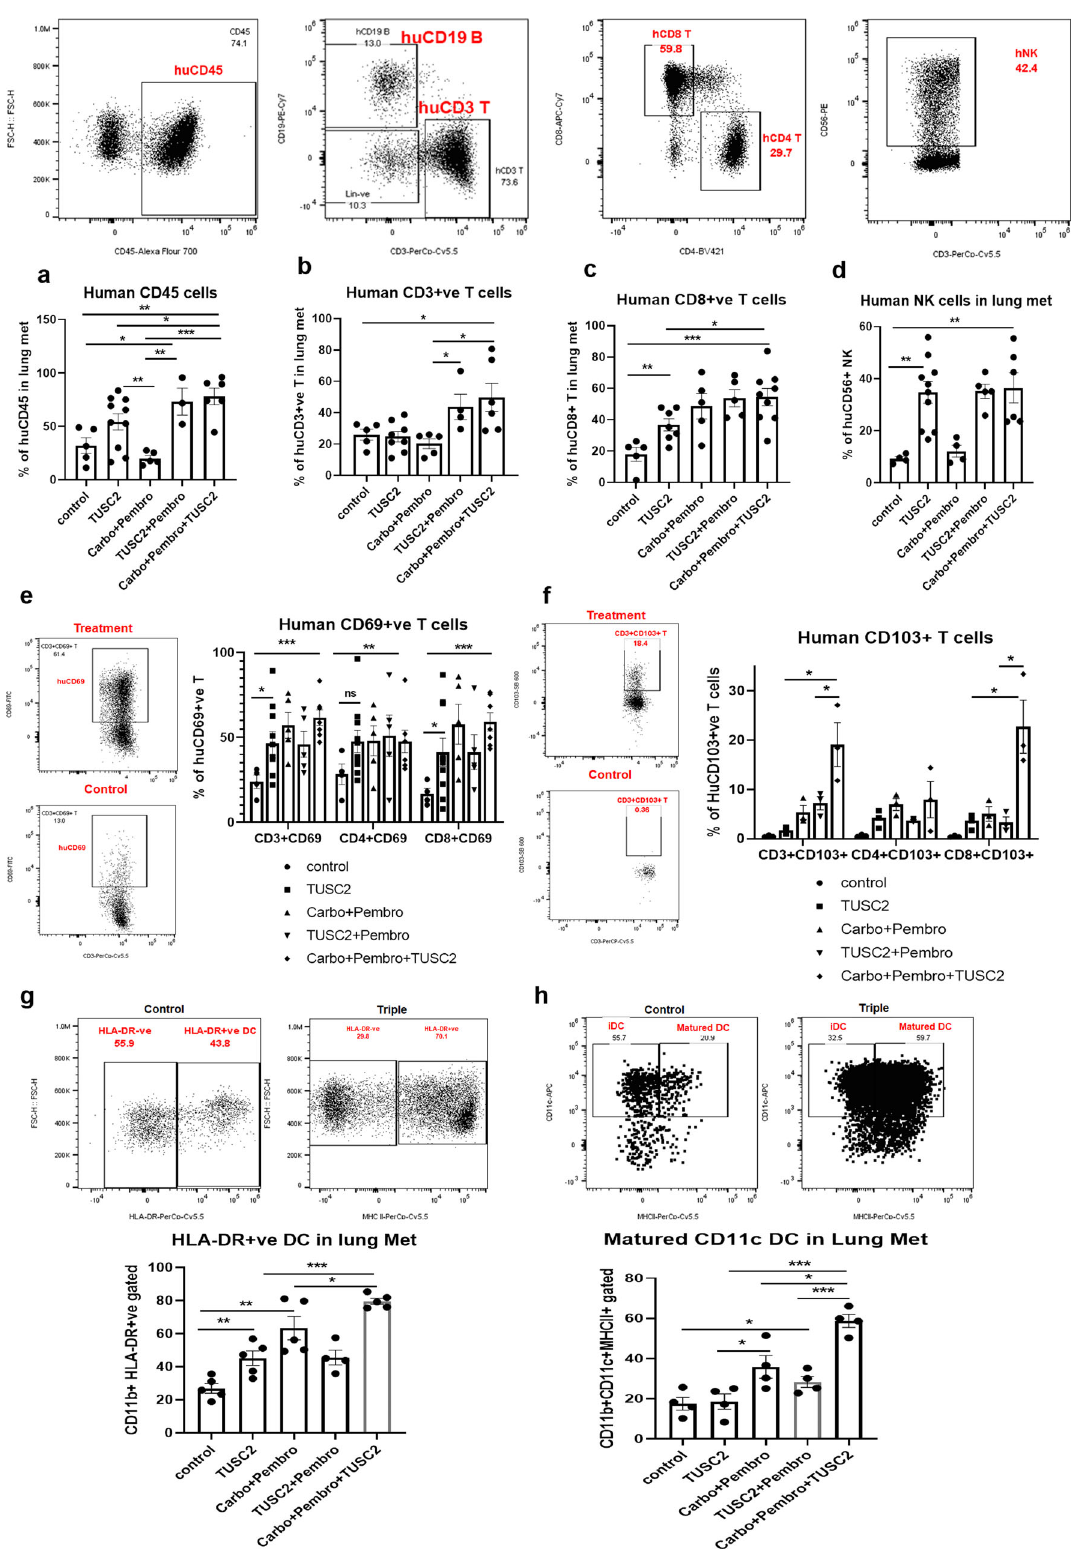
Ef fi cacy of TUSC2 plus carboplatin and pembrolizumab combination is associated with a signi fi cant decrease of immunosuppressive cells within the TME . The triple combi- nation was also associated with a signi fi cant decrease of recon- stituted tumor-in fi ltrating human immunosuppressive